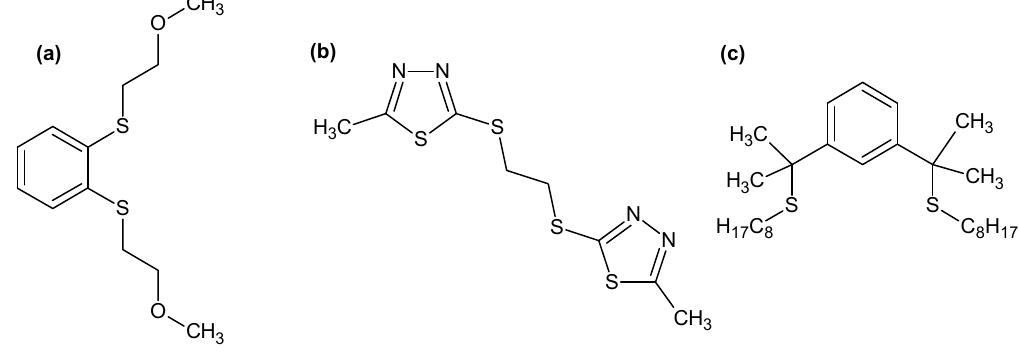
Figure 6. The structures of the best Pd(II) dithioether extractants investigated by ( a ) Holdt et al. [62], ( b ) Kondo et al. [63], and ( c ) Yamada et al.